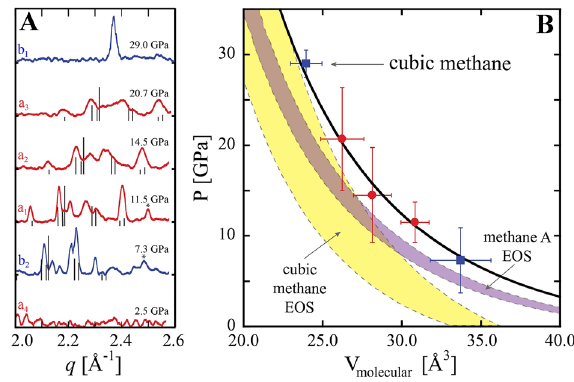
Figure 3. ( A ) Methane XRD patterns as a function of pressure. Red lines correspond to decomposition at 11.5 GPa and blue lines to decomposition at 29.0 GPa. From 7.3 to 20.7 GPa multiple peaks were indexed to methane’s rhombohedral phase A. At 29.0 GPa a single peak was observed consistent with the simple cubic HP methane phase. ( B ) Methane molecular volume, obtained from XRD peak positions, as a function of pressure. Methane A and cubic methane equations of state are shown in purple and yellow respectively, with the width of the curve representing uncertainty 23 . The solid line is the best fitting EOS to the methane A data shown here (P < 25